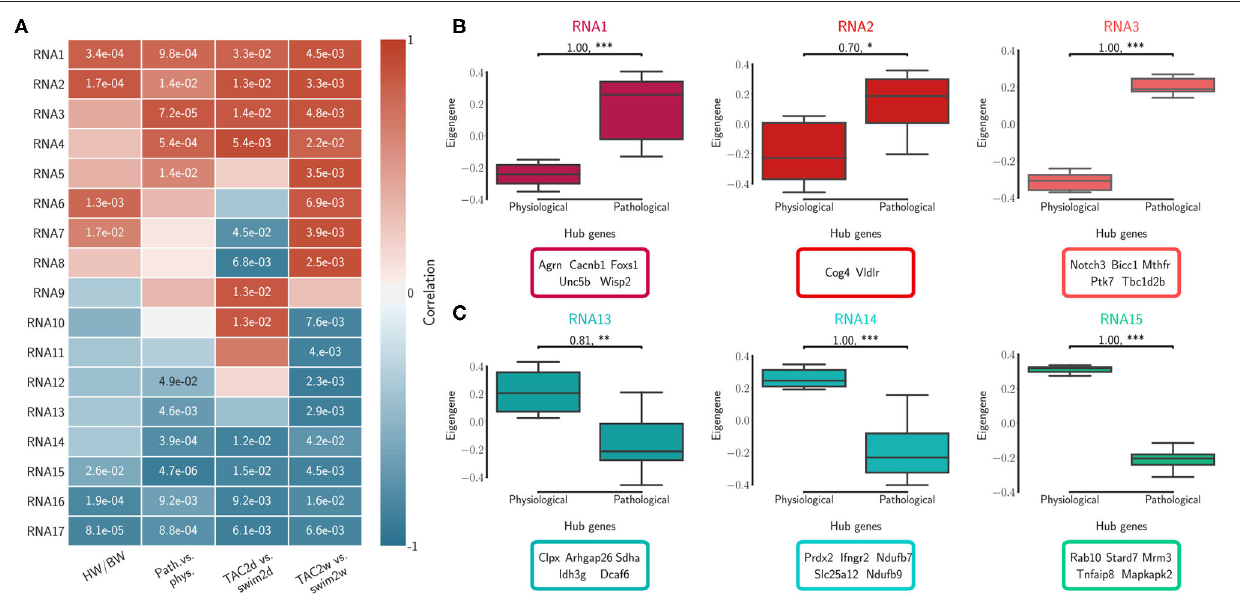
FIGURE 2 | Transcriptome (RNA) network modules were clustered to assess relatedness based on correlation of co-expressed eigengenes. (A) Biweight midcorrelation and Student correlation p -values between eigengene module expression and disease association as well as heart-weight-to-body-weight ratio. (B) The first three module expression profiles and top ranked hub genes that are positively correlated with pathological cardiac remodeling. (C) The first three module expression profiles and top ranked hub genes that are negatively correlated with pathological cardiac remodeling (i.e., positively correlated with the physiological model). Significance was measured using a one-sided Mann-Whitney U -test, at a threshold of * < 0.05 (** < 0.01, *** < 0.001, p -values may be affected by the small sample size, for this reason we also report effect size using non-directional rank-biserial correlation). Up to five hub genes are